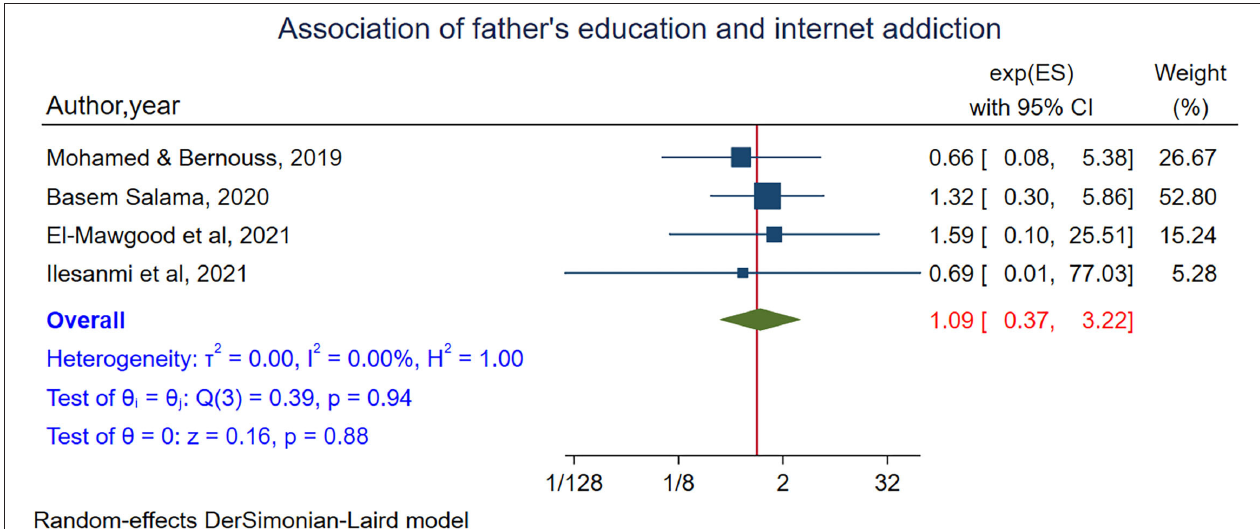
FIGURE 10 | The pooled association between fathers’ education and internet addiction.